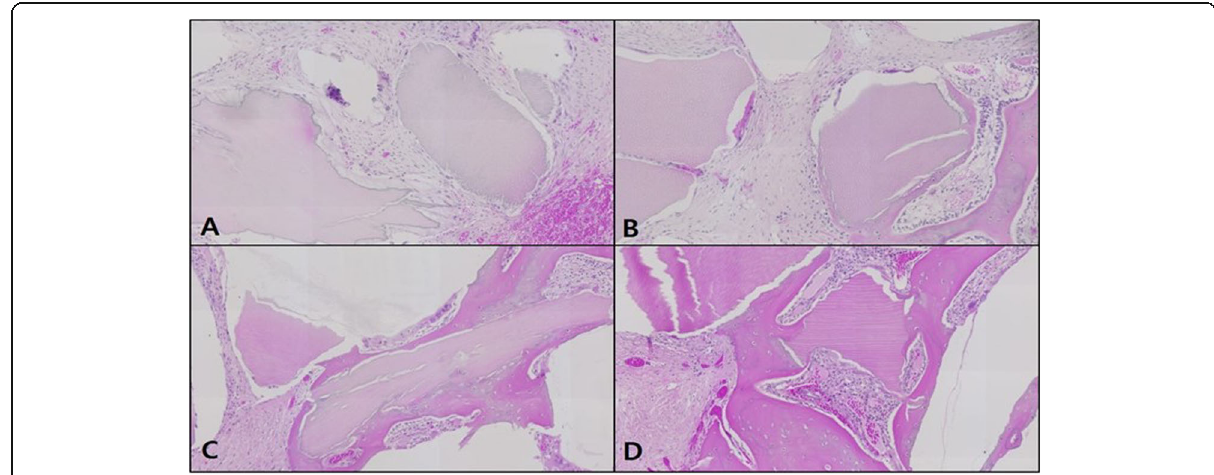
Fig. 8 Microphotograph at 1 week ( A ), 2 weeks ( B ), 4 weeks ( C ), and 6 weeks ( D ) after bone graft with organic matter removed particulate autogenous tooth in experimental rabbit. H-E.